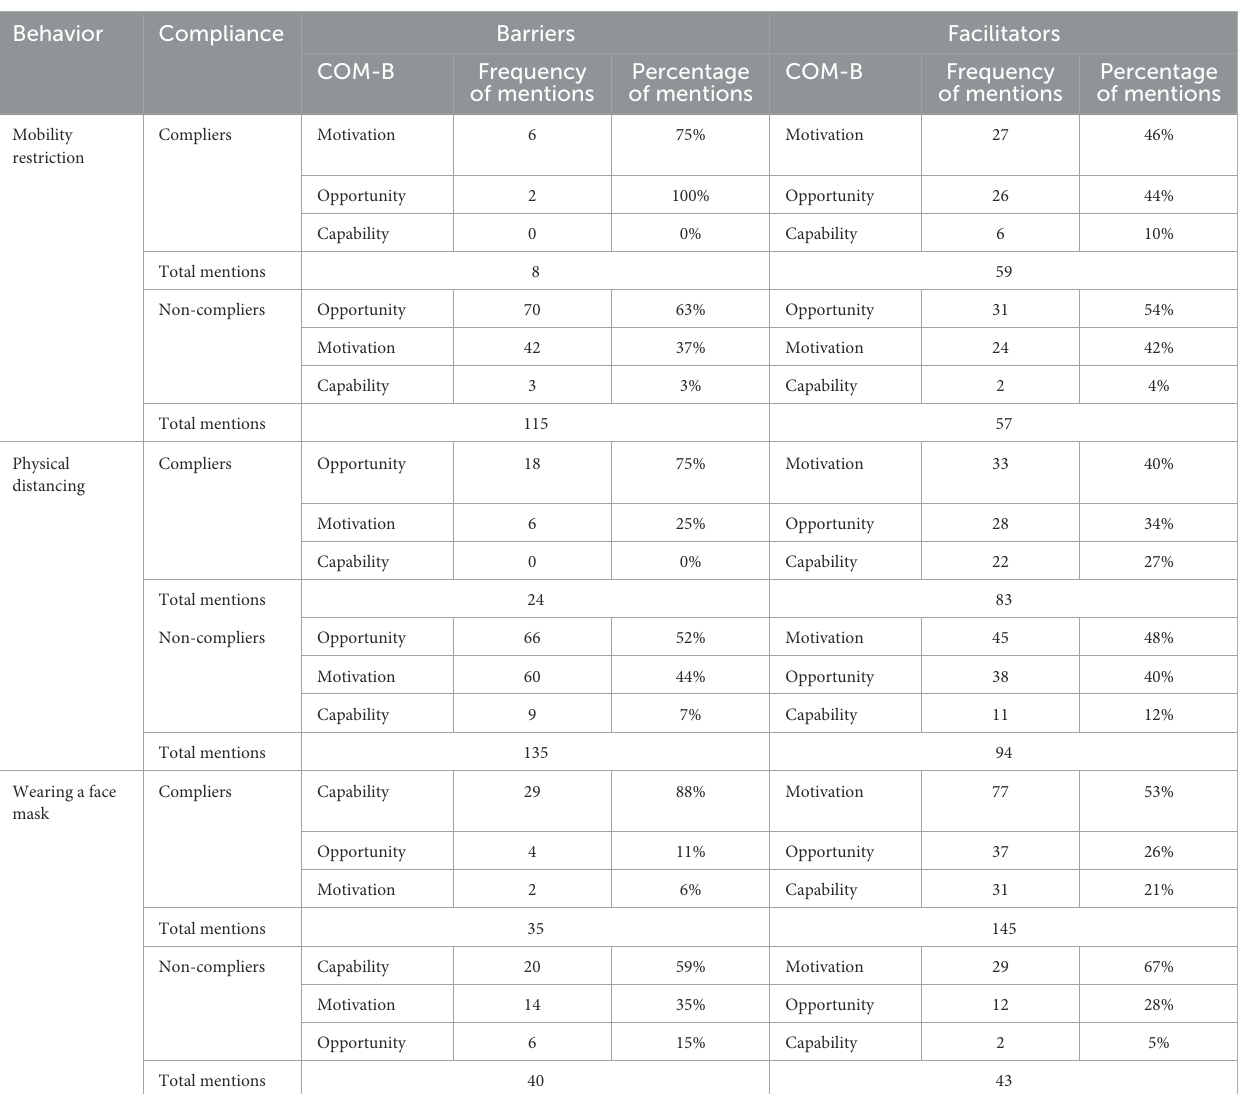
TABLE 2 Summary of COM-B